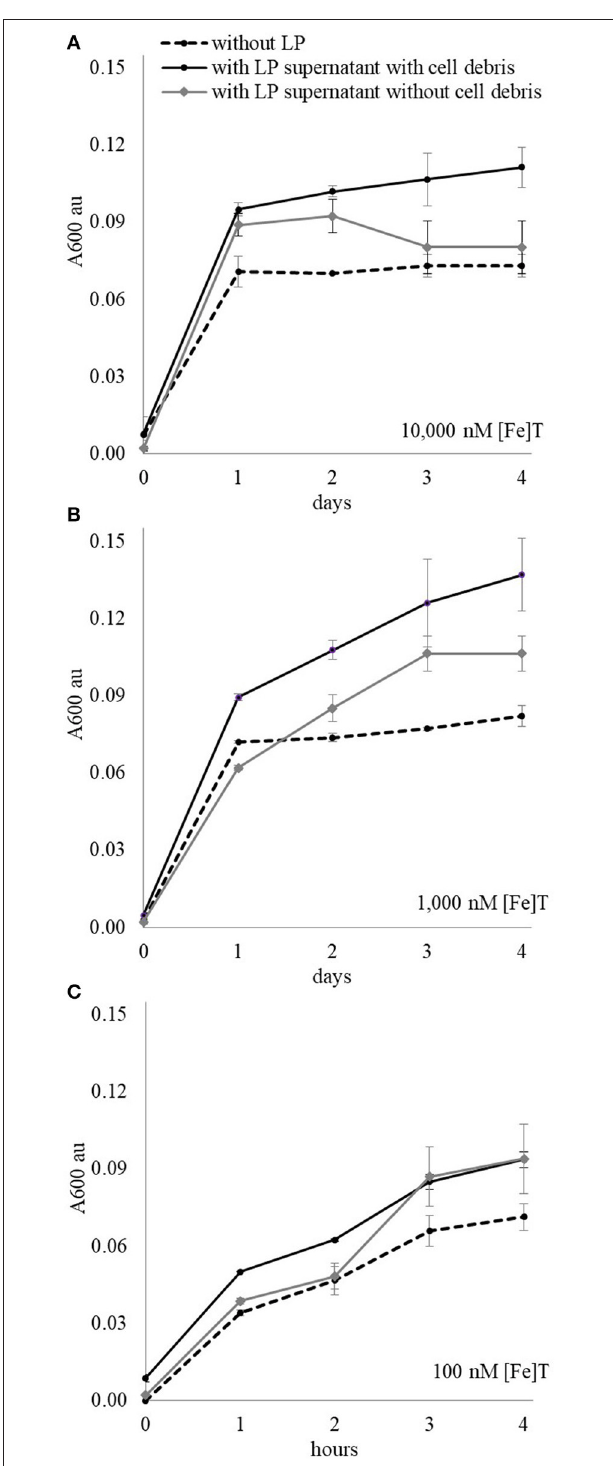
FIGURE 7 | DG893 growth in media containing different [Fe] T with and without presence of L. polyedrum supernatant and cell debris. The solid black lines represent growth of DG893 in the presence of L. polyedrum supernatant with their cell debris, the gray lines are DG893 growth in L. polyedrum supernatant without their cell debris, and the dotted lines are DG893 without any L. polyedrum supernantant . DG893 was grown in media containing (A) 10,000nM [Fe] T , (B) 1,000nM [Fe] T , and (C) 100nM [Fe] T